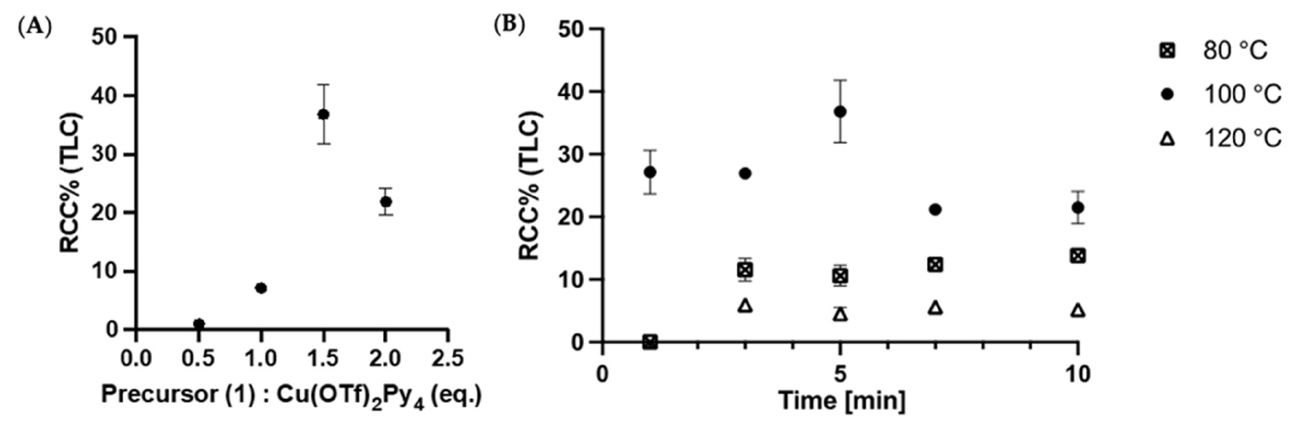
Figure 3. ( A ) Effect on RCC when adding different equivalents of Cu(OTf) 2 Py 4 (0.5, 1, 1.5, 2) with respect to a fixated precursor amount ( 2 ). ( B ) Influence on RCC when changing time and temperature. Reaction conditions: PO 43- QMA precondition, eluted with Bu 4 NOTf (20 µmol) in MeOH. Precursor 2 (3.2 mg, 10 µmol) and ( A ) different equivalent of Cu(OTf) 2 Py 4 in DMA, for 5 min at 100 ° C; ( B ) Cu(OTf) 2 Py 4 (1.5 equiv., 10 mg, 15 µmol) for different time points (3, 5, 7, 10 min) and temperature (80 ° C, 100 ° C and 120 ° C). The crude reaction was followed by radio-TLC and radio-HPLC (SI, Table S3). n = 3, error bars = standard deviation.